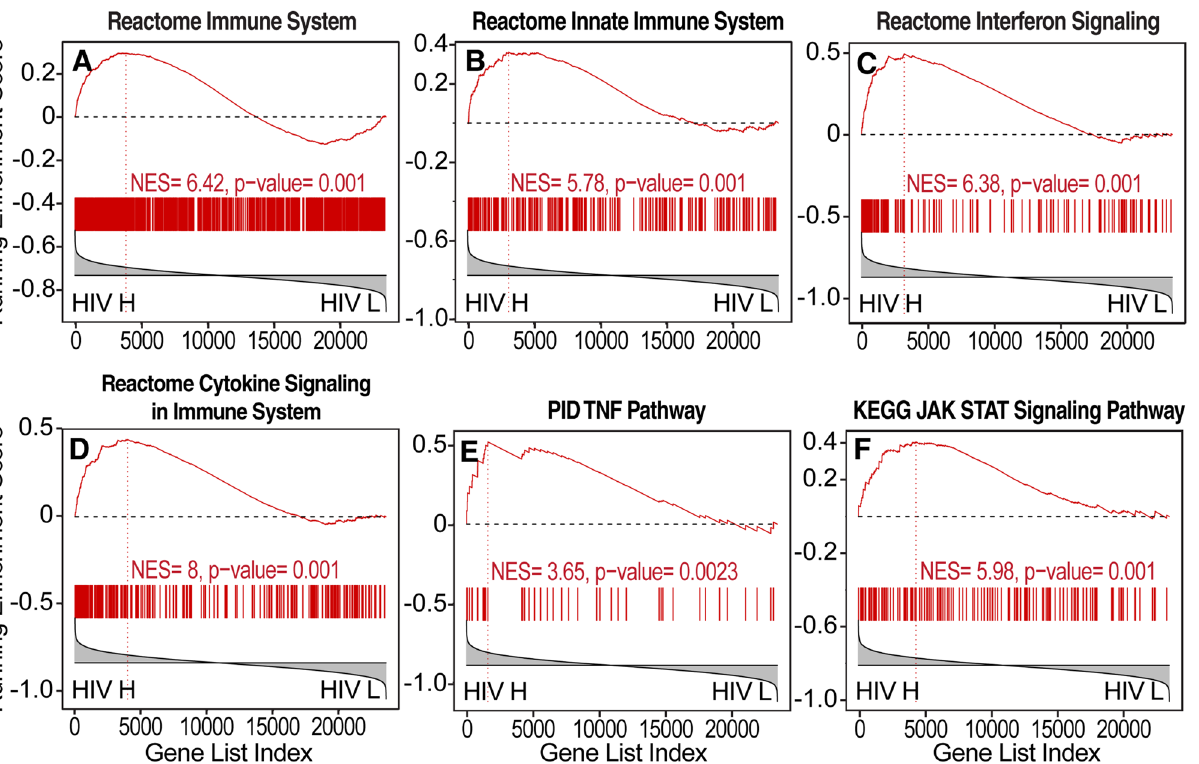
Figure 4. Increase in neuroinflammation correlated with brain HIV RNA load in the basal ganglia. ( A , B ) Pathway analysis by GSEA provided extensive evidence of immune activation and inflammation, including ( C ) increases in interferon signaling, ( D ) cytokine signaling, ( E ) tumor necrosis factor α (TNF-α) signaling, and ( F ) JAK STAT pathway activation. HIV H, high brain HIV RNA load; HIV L, low brain HIV RNA